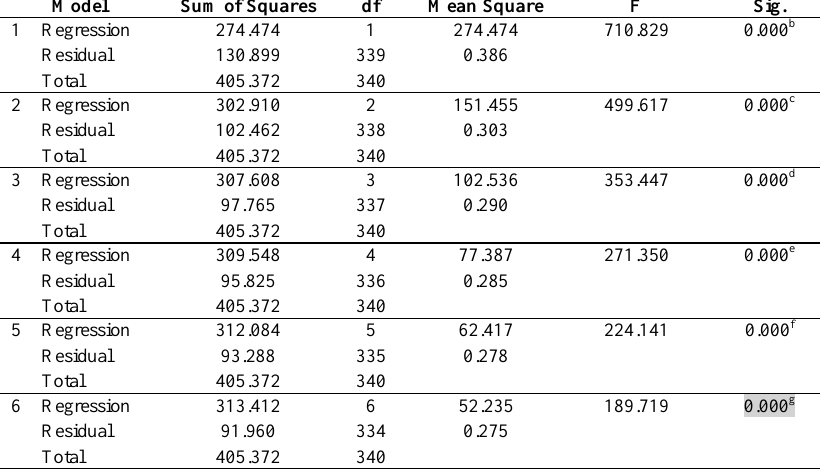
Table 3. Model F-test